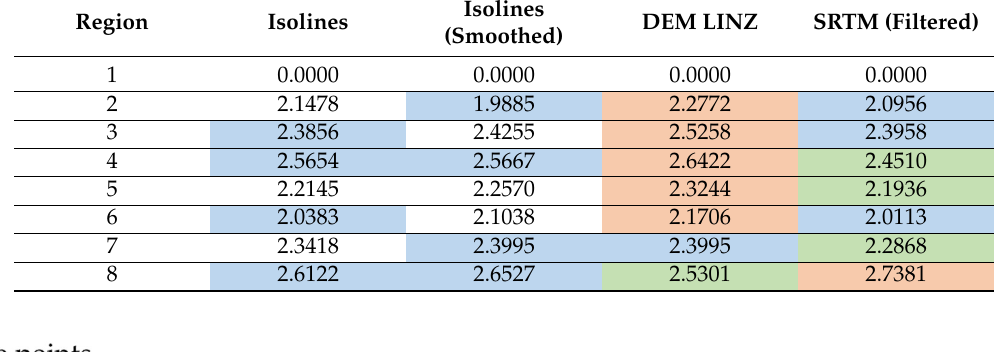
Table 4. Geomorphological values generated by 4 different methods of slope generation. The blue color highlights similar values between models in our region. The orange color highlights models with a result considered too high in comparison to other models in that region. The green color highlights those models where we consider the results too low in comparison to others in that region. Colour codes showing tha calculated categories of each region applying various DEM input data. Region Isolines